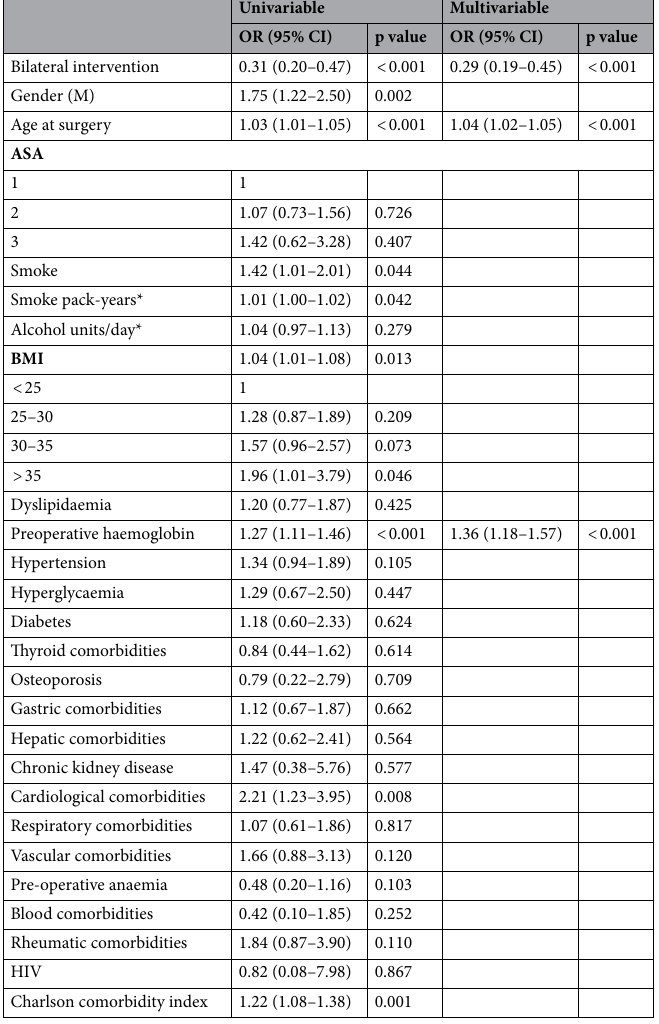
Table 2. Univariable and multivariable logistic regression assessing risk factors for local